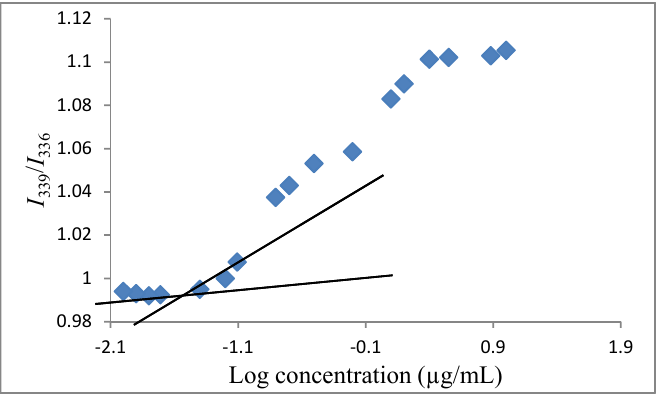
Figure 11. Dependence of intensity ratio I function of Y-shaped-PEG–(PCL)